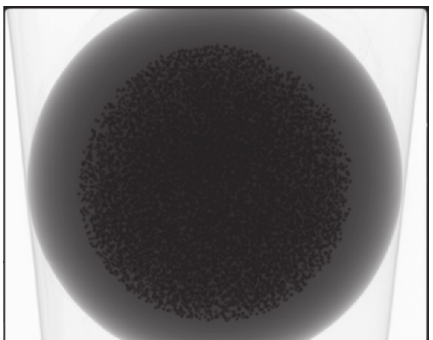
Figure 2: Raw DR of a fuel